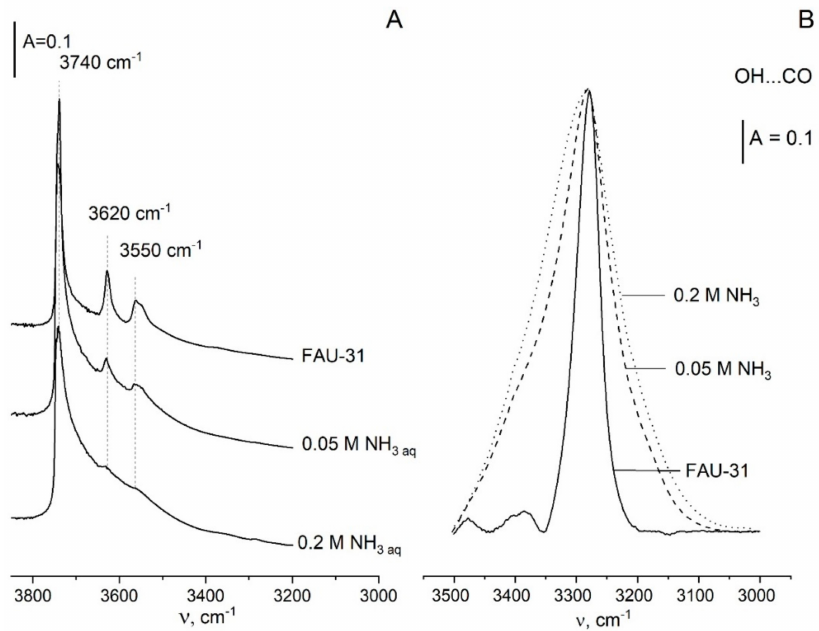
Figure 3. IR spectra of free OH groups ( A ) and OH groups hydrogen bonded with CO ( B ) in the parent zeolite and samples treated by ammonia solutions. Figure adapted with the permission from